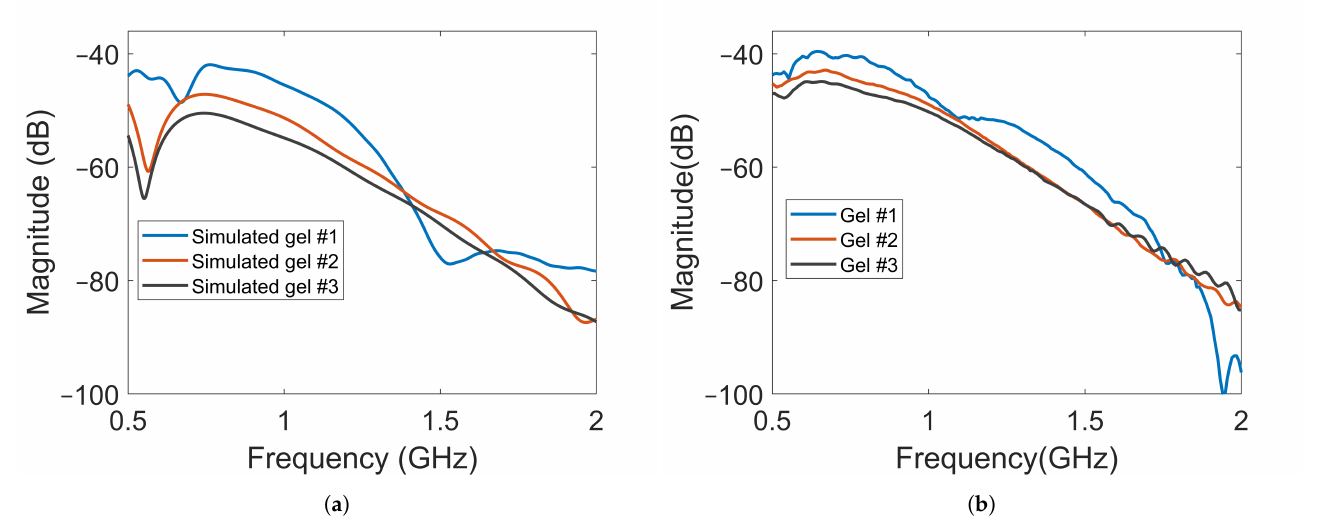
Figure 11. Magnitude of transmission coefficients between the transmitting antenna and Probe B for Gel #1, Gel #2 and Gel #3: ( a ) simulated transmission coefficients; ( b ) experimental transmission